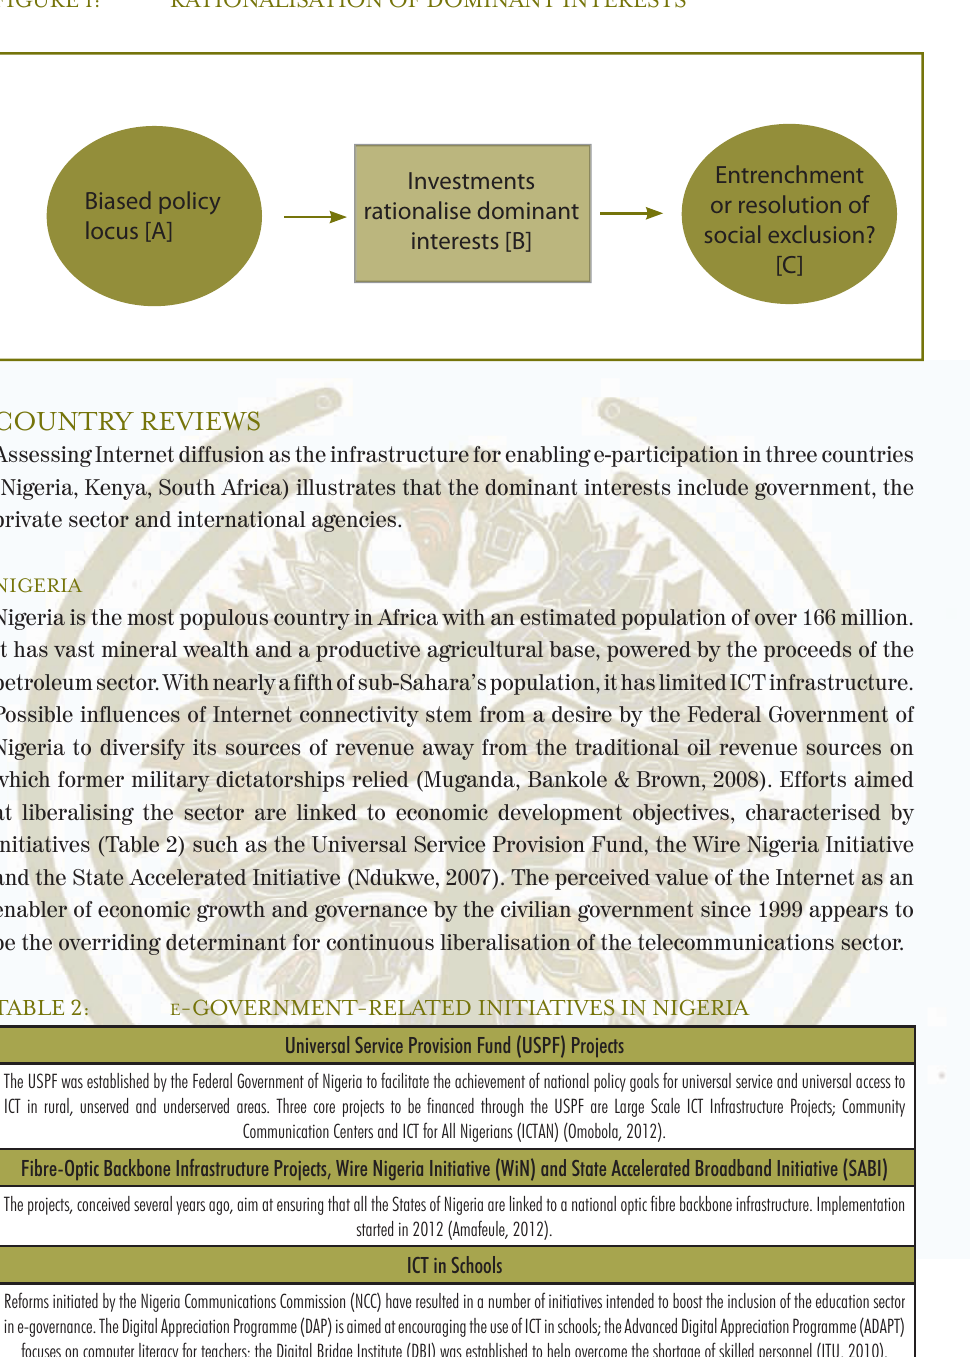
FIGURE 1: RATIONALISATION OF DOMINANT INTERESTS